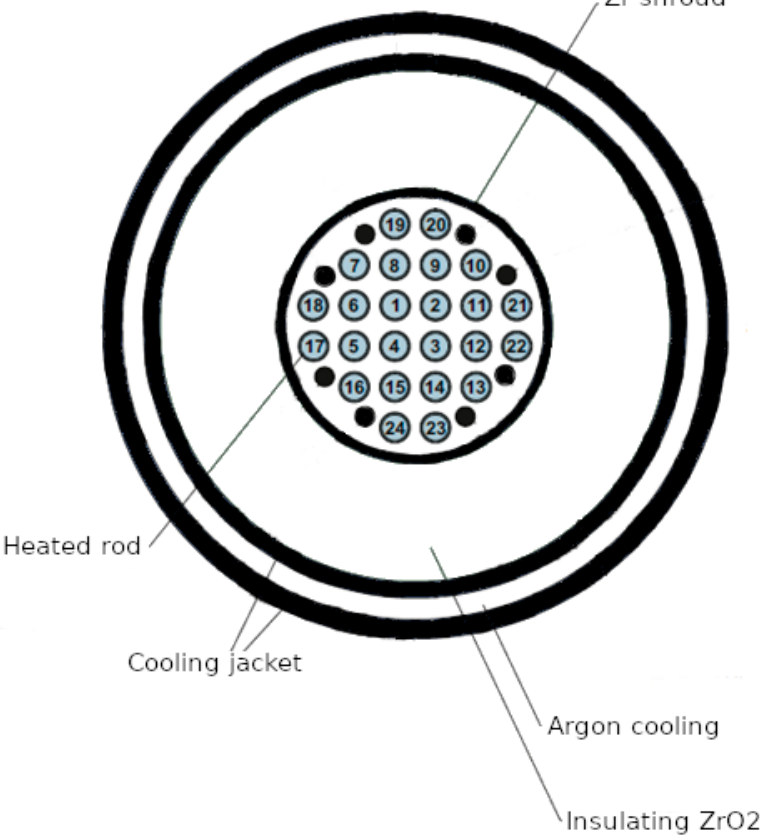
Figure 1. Cross-section of the test bundle